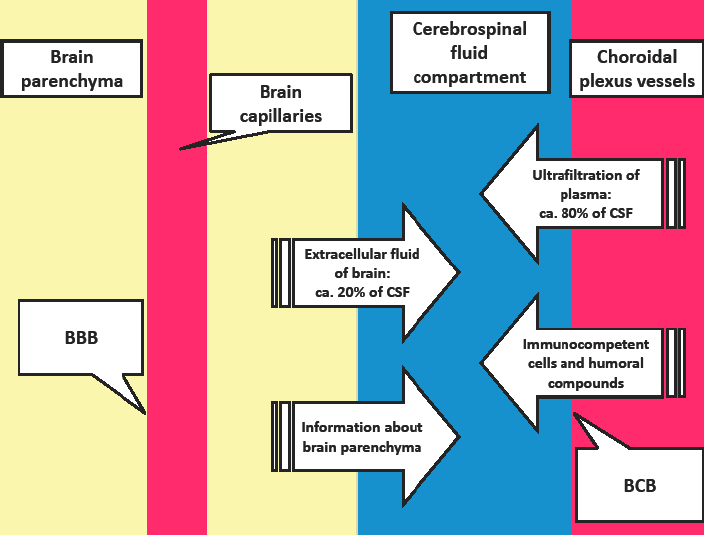
Figure 1. Schematic representation of CSF production. BCB: Blood-Cerebrospinal Fluid Barrier; BBB: Blood-Brain